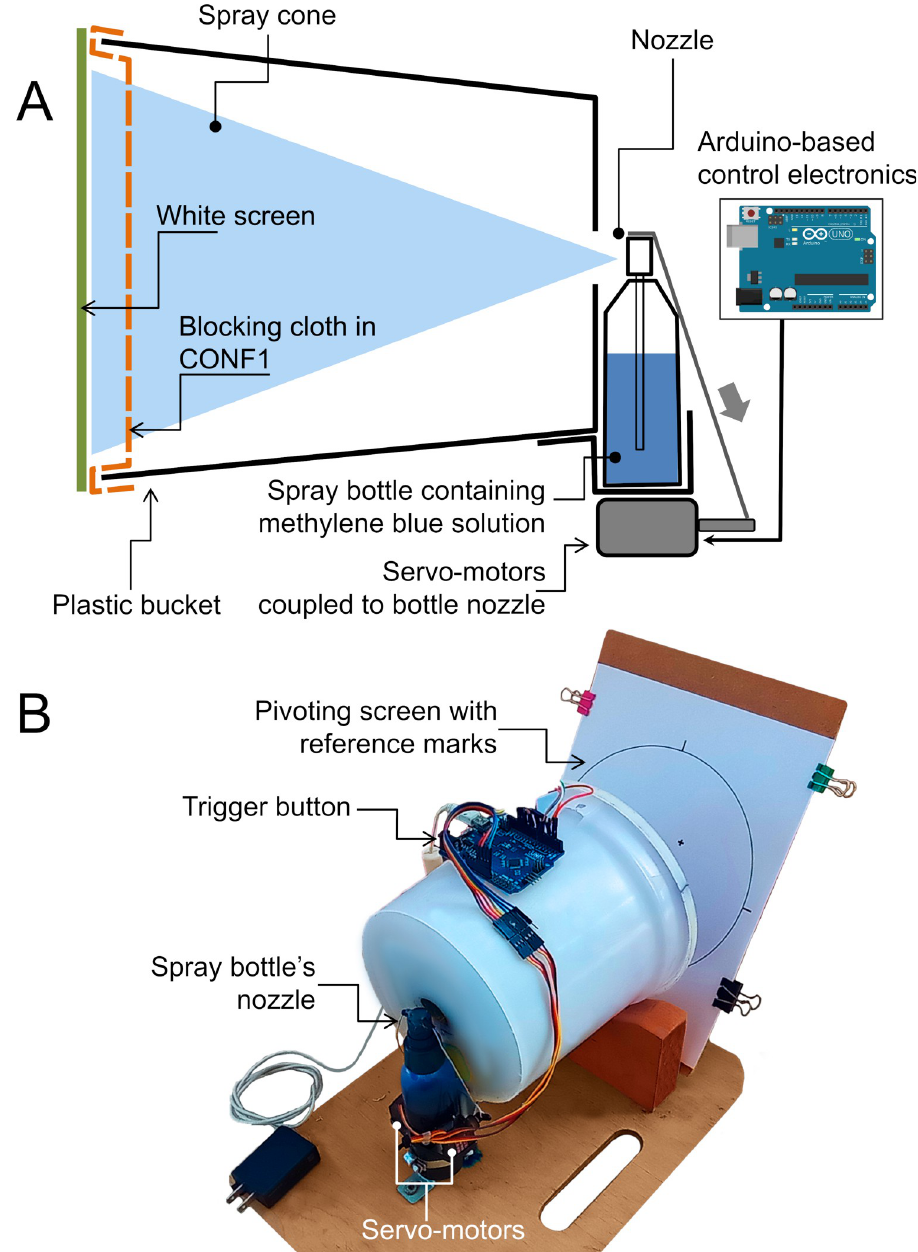
Fig 1. Experimental setup. (A) Sketch of the experimental setup, illustrating a cloth deployed in CONF1 (i.e., located 1.5 cm apart from the screen). (B) Photograph of the real device. The device is partially open so the screen can be seen, but not the blocking